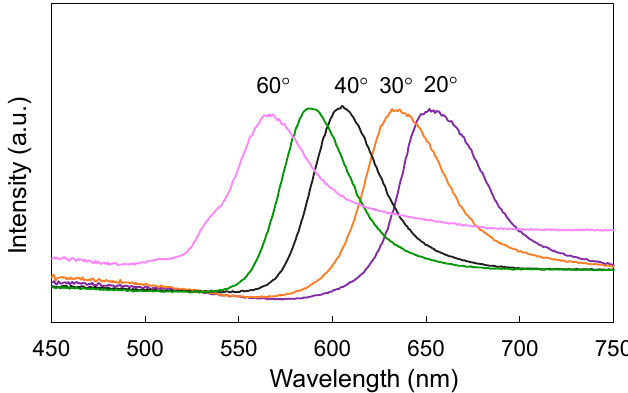
Figure 4. Angle dependance of PBG for silica opal (opal-295).